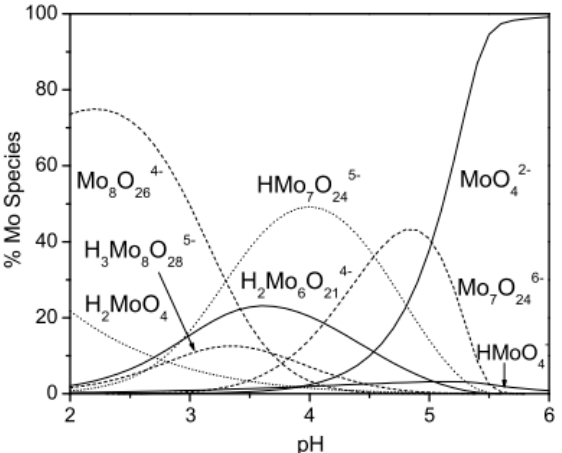
Figure 8. Distribution of Mo species in function of pH (initial molybdenum concentration = 10 mM), taken from [122].